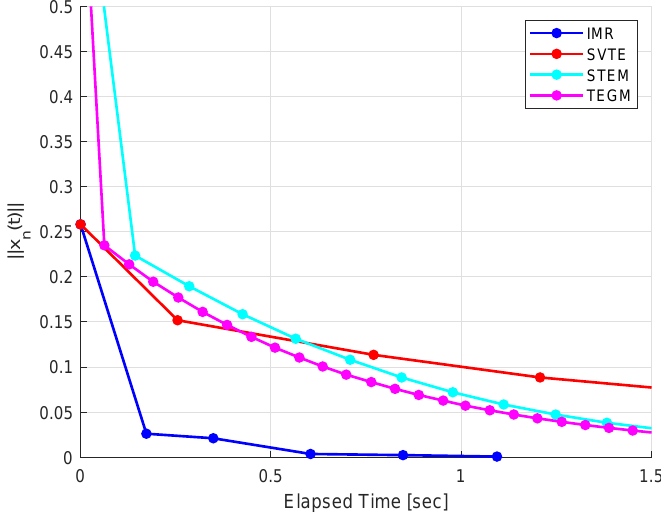
Figure 3. Example 2, x 0 ( t ) = t 2 + t 6 and x 1 ( t ) = t 7 .